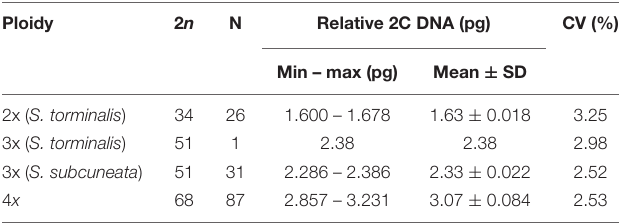
TABLE 3 | Nuclear DNA content (pg) of each of the clusters with inferred ploidy and chromosome number (2 n ).